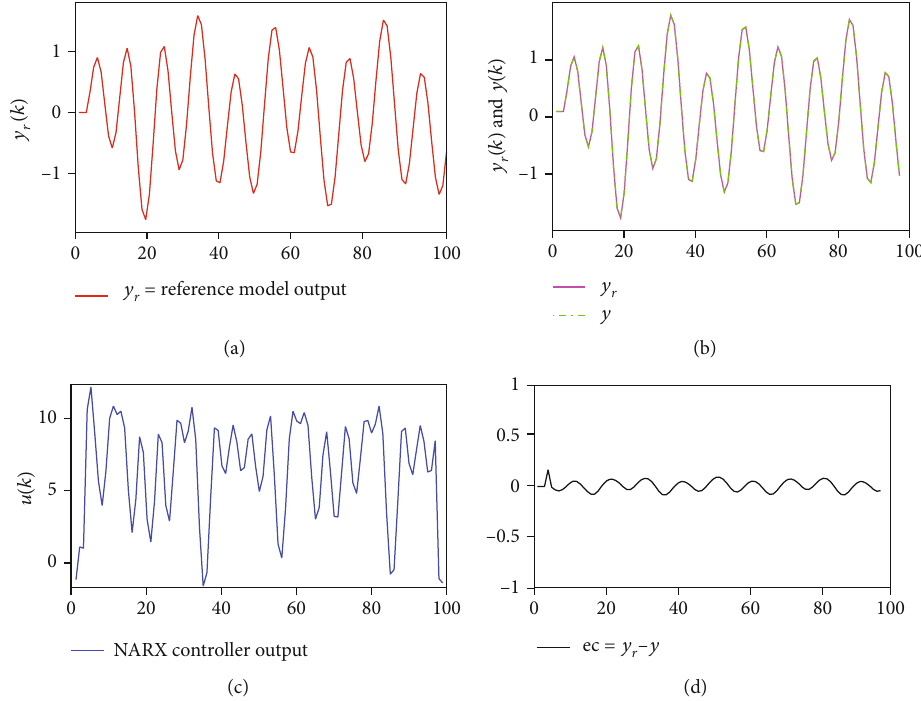
Figure 14: Example 3: (a) response of the reference model, (b) response of the plant under the adaptive controller, (c) NARX controller output, and (d) control error (using n = 2 and m = 2